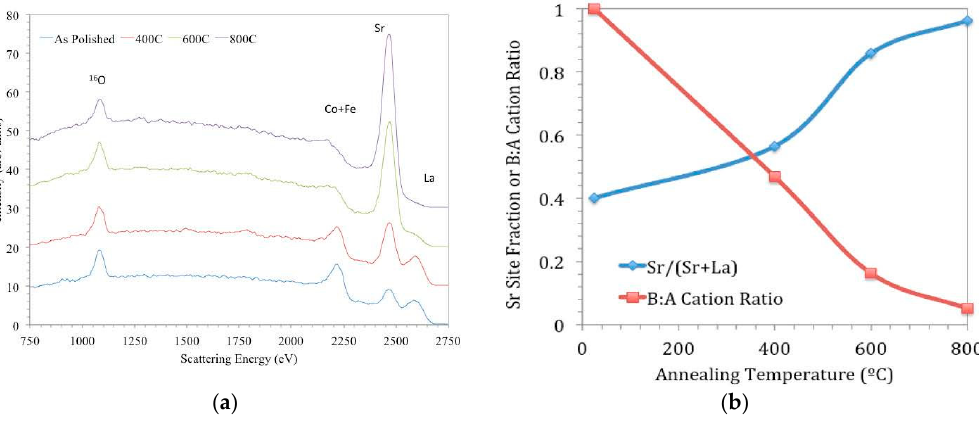
Figure 10. ( a ) LEIS spectra using 3 keV 4 He + primary beam for LSCF ceramics annealed for 8 h at various temperatures. Adapted from [97] by Druce et al. with permission from Elsevier; ( b ) Fraction of Sr on A-site and B:A cation ratio quantified from spectra in ( a ). A sequence of LEIS spectra can also be obtained after stepwise removal of material by low energy (500 eV) Ar ion sputtering to provide depth profiles of elements. By this approach, one may, for example, study not only the outer monolayer chemistry but also the sub-surface region after Sr surface enrichment/segregation has occurred. Figure 11 (from [98]) shows sample LEIS spectra (partial energy range) at different depths and a resulting depth profile measured on a LSCF ceramic sample after annealing for 12 h at 1273 K.